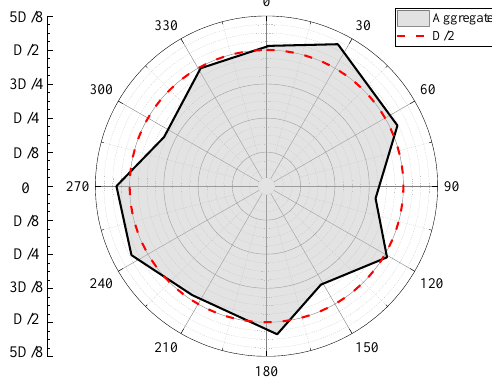
Figure 2. Aggregate generation in polar coordinates.